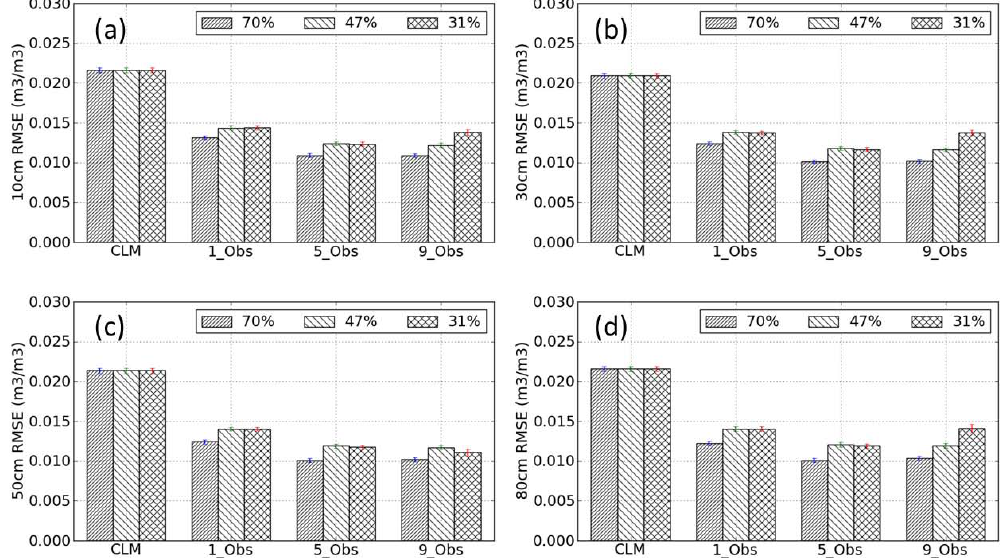
Fig. 7. This figure shows the mean basin scale soil moisture RMSE values (including 95% confidence intervals) for open loop simulations (CLM) and three assimilation strategies of 1 observation used (1 Obs), 5 observations used (5 Obs), 9 observations used (9 Obs) at all grid